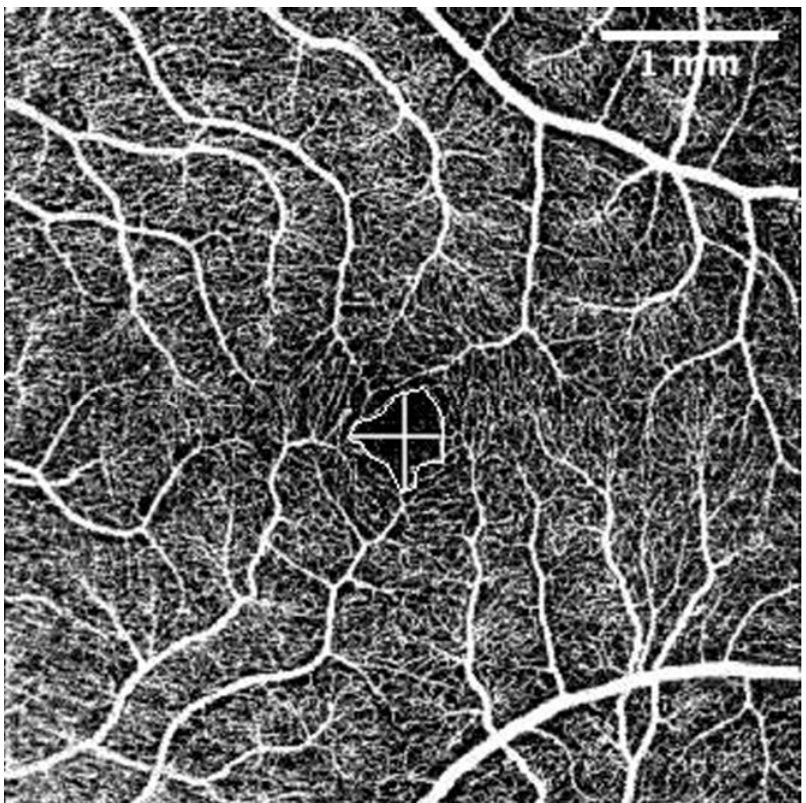
Figure 2. Superficial capillary layer OCT ‐ A. FAZ perimeter, horizontal, and vertical diameters. The intraobserver repeatability of 30 randomly chosen tomograms was excellent (Pearson’s correlation coefficient (PCC) = 0.9). The scale was 71.11 pixels/mm; knowing the size of the tomogram (4.5 × 4.5 mm, 320 × 320 pixels), the FAZ area was measured by connecting the terminal points of vessels that form the FAZ. Horizontal and vertical diameters were measured at the largest points of the FAZ horizontally and vertically, respectively. Terminal vessel counts were the number of terminal vessels that formed the vessel circle around the FAZ. (Images were acquired with DRI OCT Triton plus (Ver.10.13). Final image was finished using ImageJ program and Clip Studio Paint PRO